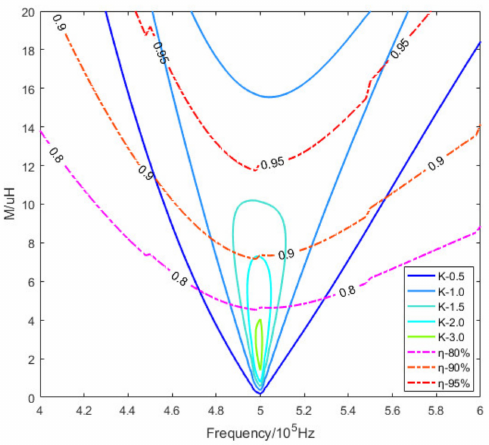
Figure 5. The partial contour diagram of K and η